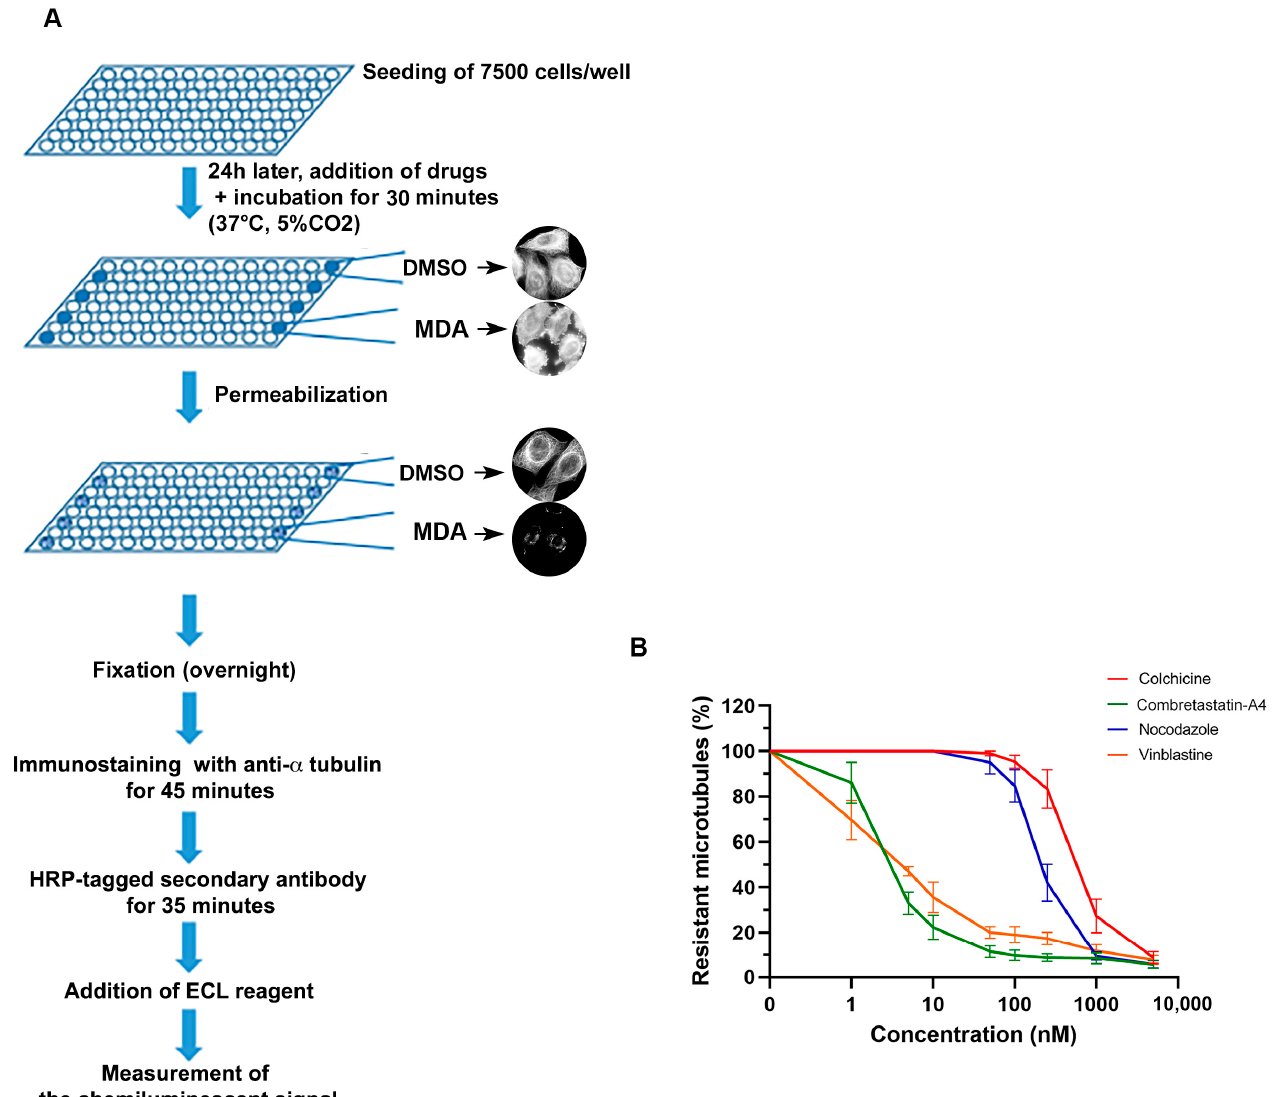
Figure 3. Comparative analysis of the effect of the selected microtubule depolymerizing agents on microtubule contents in HeLa cells. ( A ) Schematic representation of the different steps of the assay. ( B ) Comparison of the MT destabilizing effect of the reference compounds. Different doses of compounds were applied to HeLa cells in microplates and their MT destabilizing effect was assessed after a 30 min incubation, using the luminescent assay, as described in the Materials and Methods section. Results are expressed as % of resistant MTs, with 100% corresponding to cells treated with DMSO only without the depolymerizing agent. Datapoints are means ± SEM from three independent experiments.